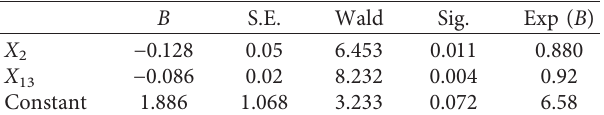
Table 4: Final variables.